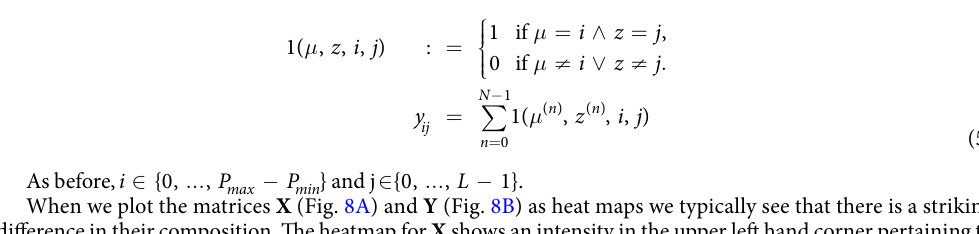
1} . When we plot the matrices X (Fig. 8A) and Y (Fig. 8B) as heat maps we typically see that there is a striking difference in their composition. The heatmap for X shows an intensity in the upper left hand corner pertaining to